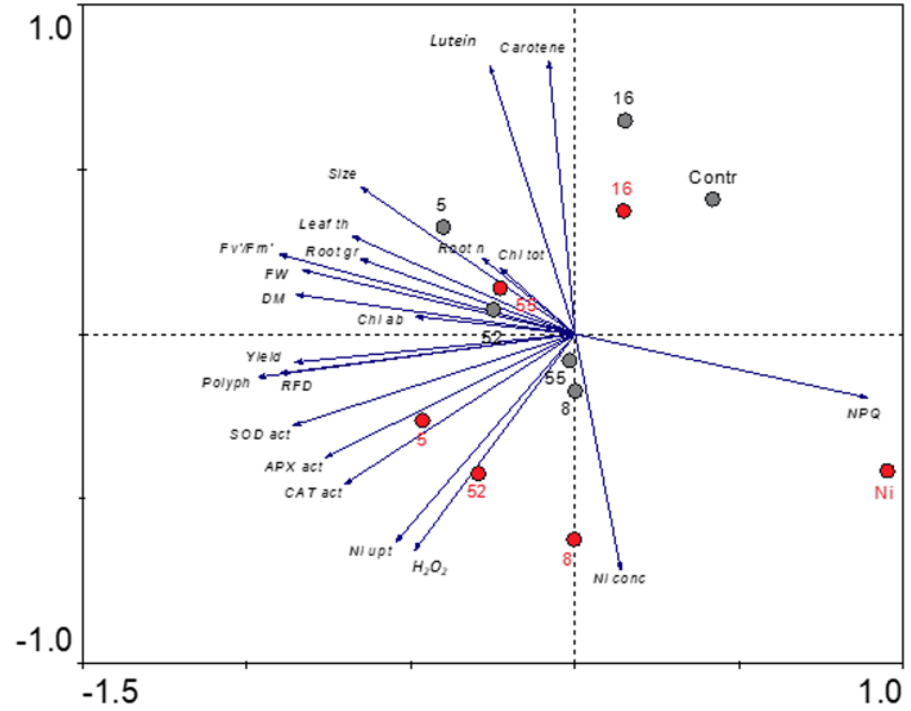
Figure 11. Principal component analysis (PCA) ordination biplot based on Arabidopsis response to inoculation with rhizobia strains and Ni-stress. Vectors indicate the response parameters and circles mark the rhizobia strains: without Ni (grey), with Ni (red). Values next to the axes represent the percentage of explained variability.